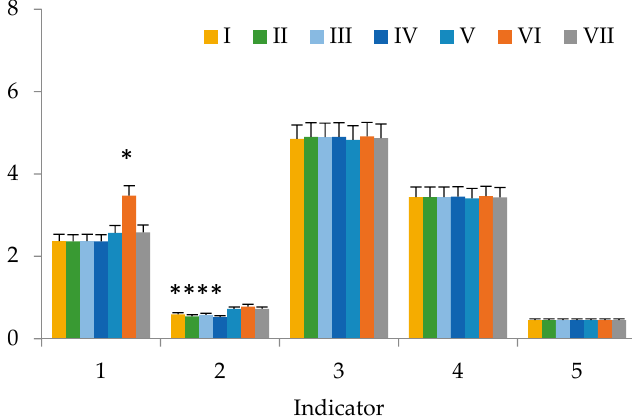
Figure 1. Biochemical and hematological indices of blood of animals from groups I–VII: 1—Cholesterol, mmol/L; 2—Triglycerides, mmol/L; 3—Bilirubin, μ mol/L; 4—Number of leukocytes, g/L; 5—Hematocrit, L/L (bars in graphs indicate the SE of 15 replicates). Values with «*» do differ significantly ( p > 0.05).